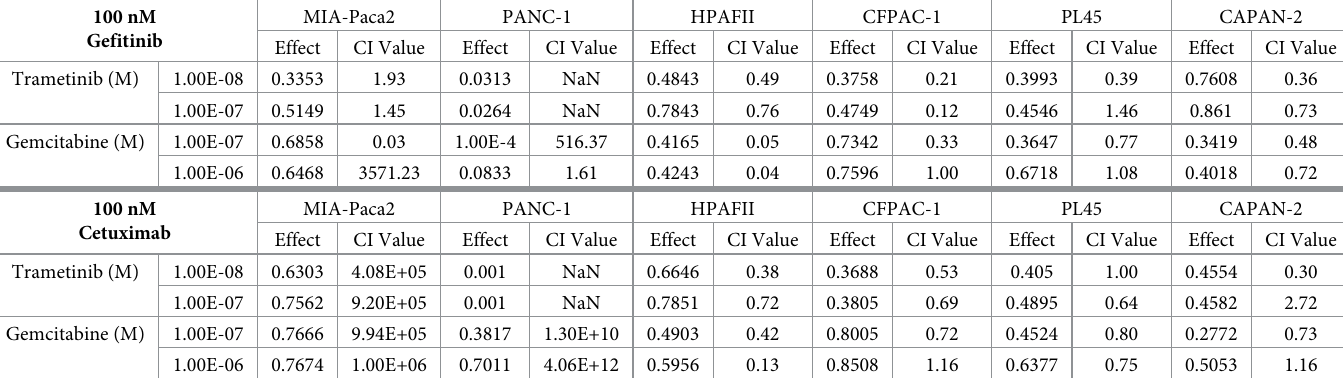
Table 4. Chou-Talalay CI values in EGFR inhibitors combination treatment with gemcitabine and trametinib. 100 nM Gefitinib